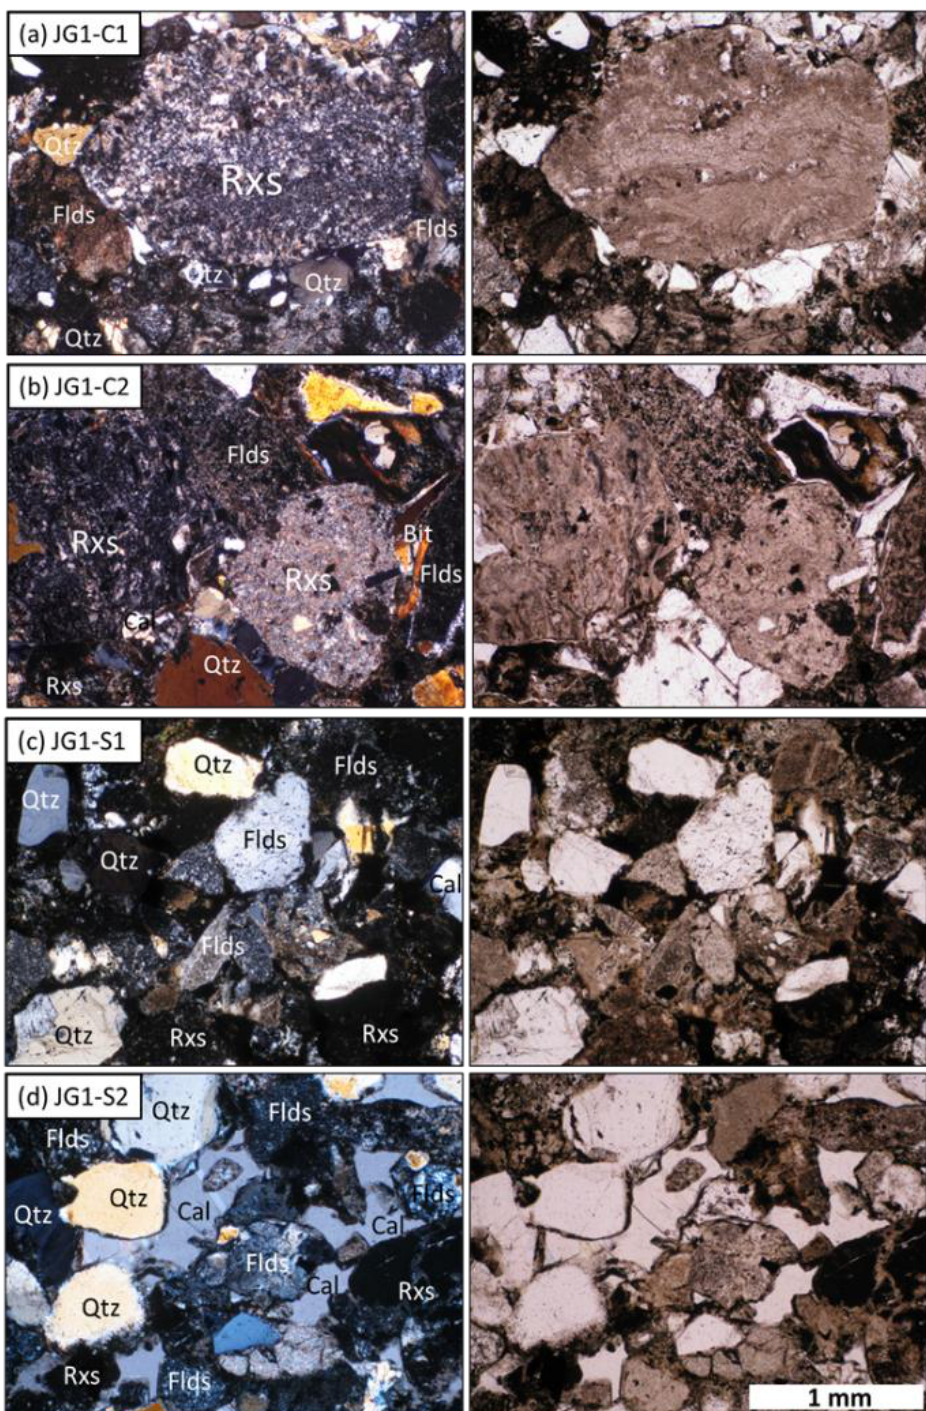
Figure 4. Photomicrographs of thin sections of the conglomerate ( a , b ) and the rudaceous sandstone ( c , d ); left column—closed mode; right column—open mode; Qtz—quartz; Flds—feldspars; Cal—calcite; Bit—biotite; and Rxs—rock fragments.